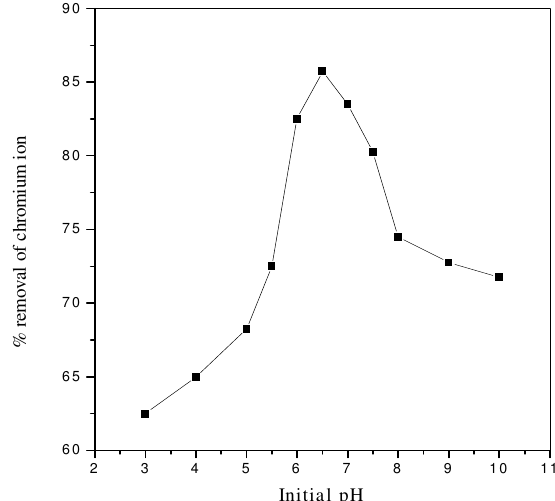
Initial pH Figure 6. Effect of initial pH on the removal of chromium ion by PDC [Cr]=20 mg/L, Dose=50 mg/50 mL; Contact time =60 min